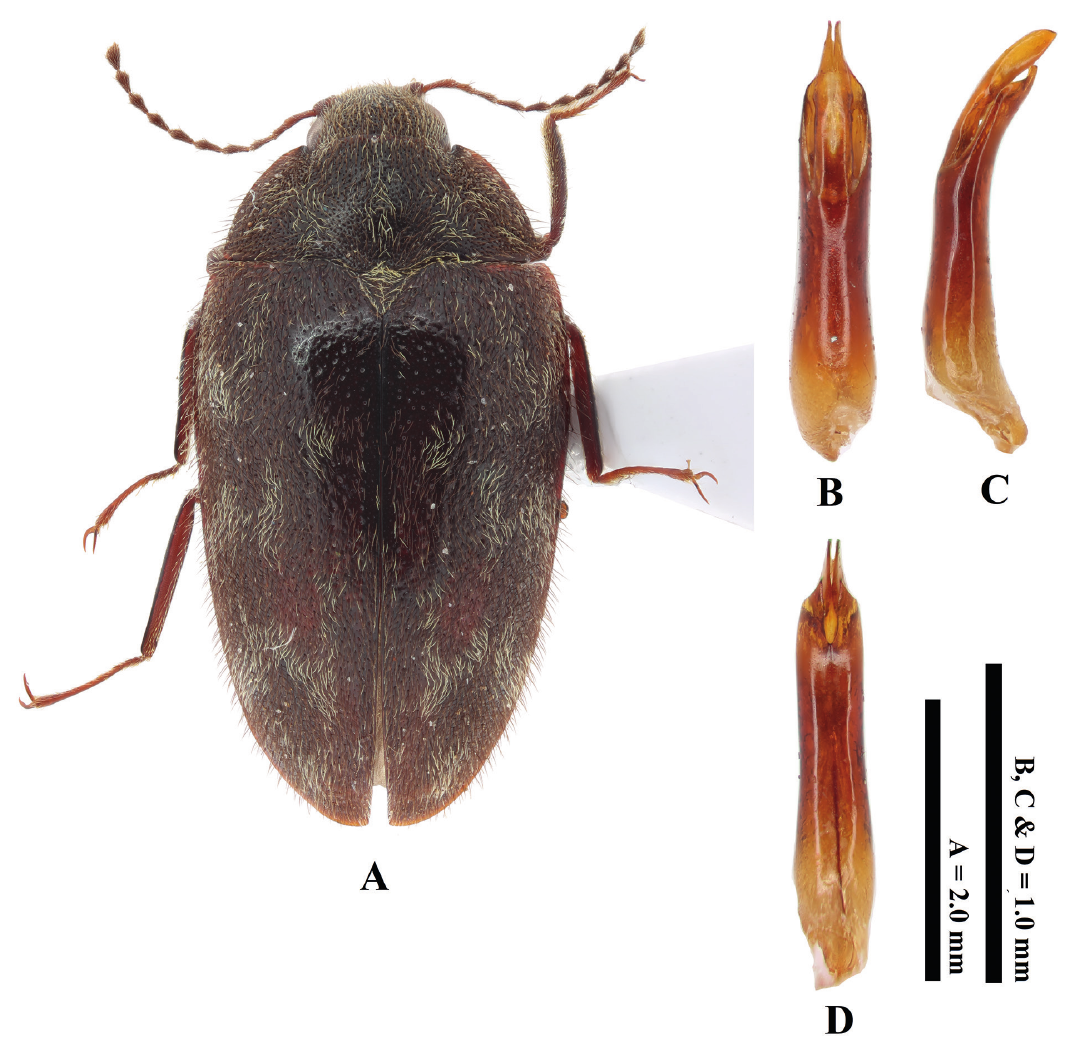
Fig. 1. Caccothryptus brendelli sp. nov., ♂, holotype (NHMUK011225276). A . Dorsal